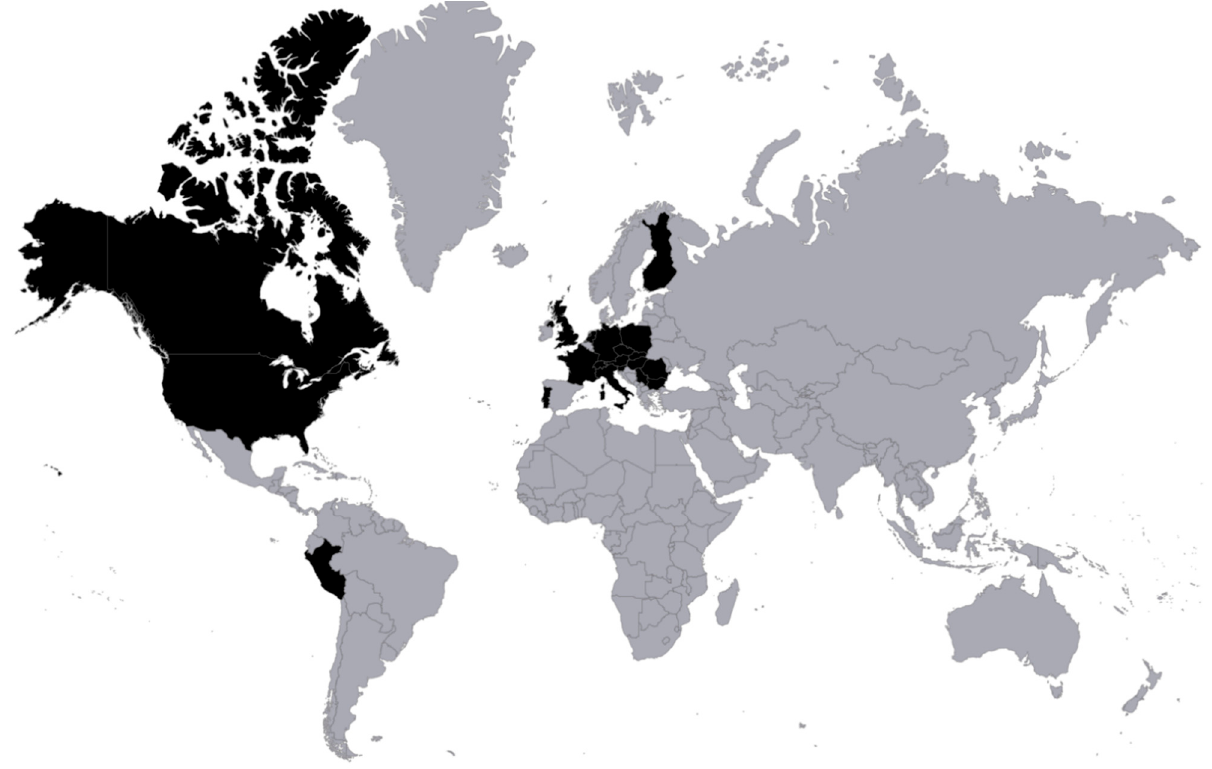
Figure 3. Countries of origin (highlighted in black) of registered patients seeking help at the PTU in the years 2005–2021 (source: internal documentation) .